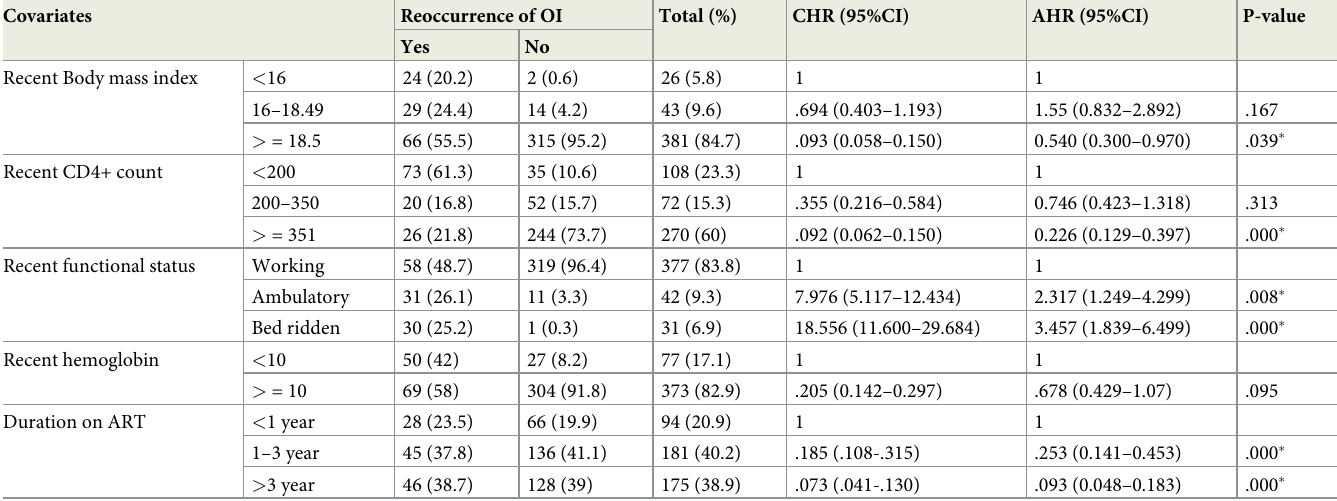
CHR, crude hazard ratio; CI, confidence interval; AHR, adjusted hazard ratio. � p-value less than